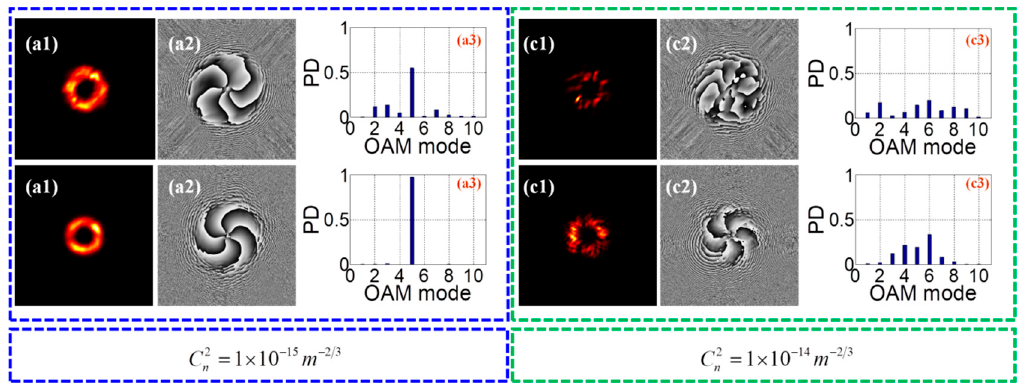
Figure 7. Intensity, phase and power density spectrum distribution of OAM beams ( l = 5) without and with the pre-compensation of GS algorithm under simulated atmospheric turbulence with di ff erent refractive index structure parameter C 2 n valued as 1 × 10 − 15 m − 2/3 , 1 × 10 − 14 m − 2/3 for phase screens number N = 150. (a1, a2, a3) and (c1, c2, c3) are respectively intensity, phase and power density spectrum without pre-compensation, (b1, b2, b3) and (d1, d2, d3) are their corresponding are power density with pre-compensation.